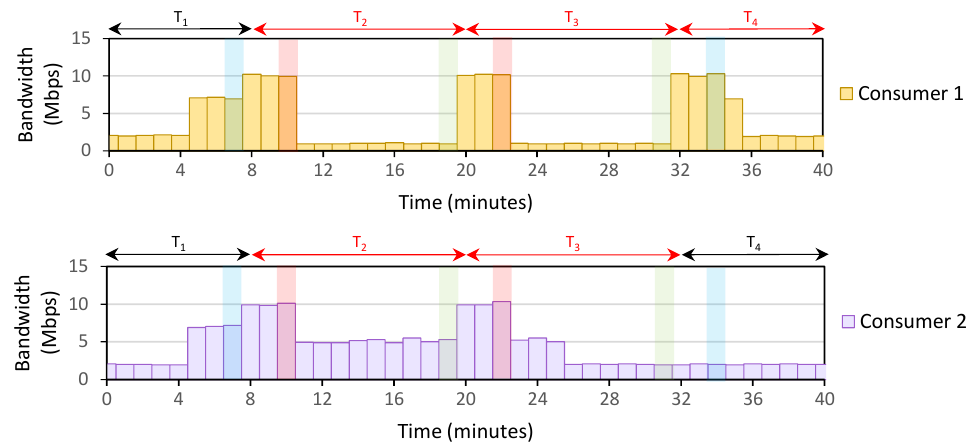
Figure 7. An example of a traffic pattern that follows Rules 1 – 3 (Scenario 3). Green, blue, and red bars point to density changes in off-peak, normal, and peak. The red color of T n indicates the point-of-interest timeslot, where we sent the 900 MB